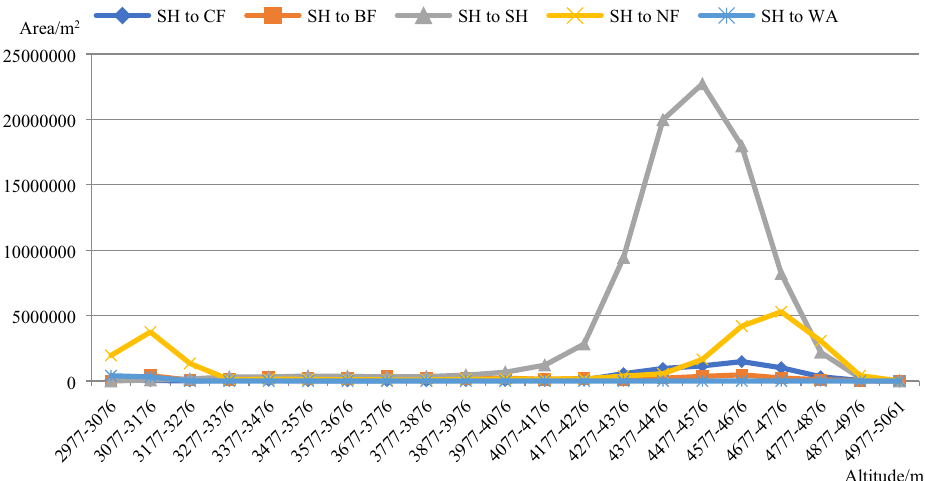
Figure 8. Distribution of the changed and unchanged SH area in the 21 altitude gradients between 2013 and 2015. The figure is generated using the Microsoft Office 2016 (http:// www. office.